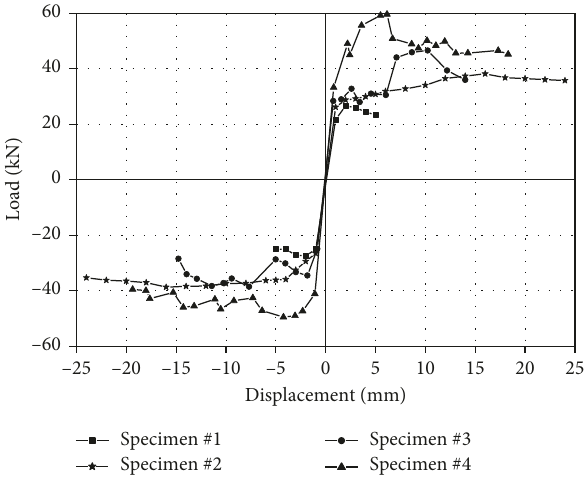
Figure 5: Comparison of skeleton